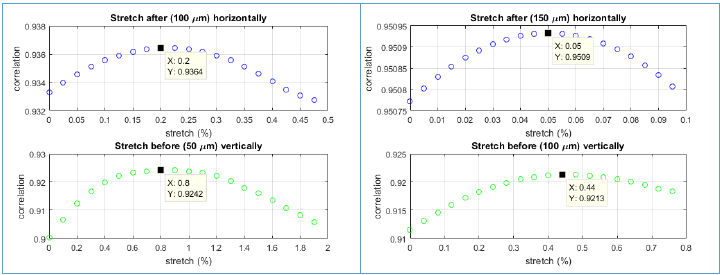
Figure 7. Results from one-dimensional image correlation method in space-domain.